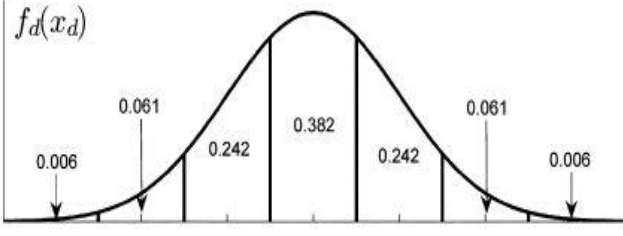
Figure 2. Seven-interval approximation of probability density function (PDF).